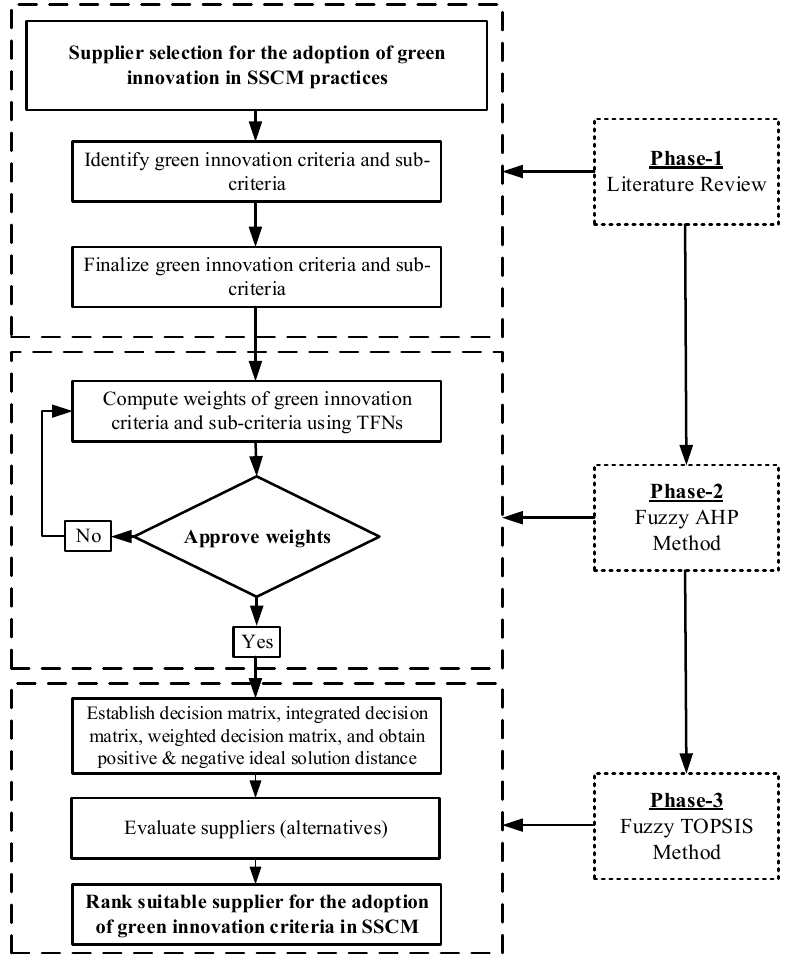
Figure 1. The decision methodology of the study. Table 3. The triangular fuzzy number (TFN)